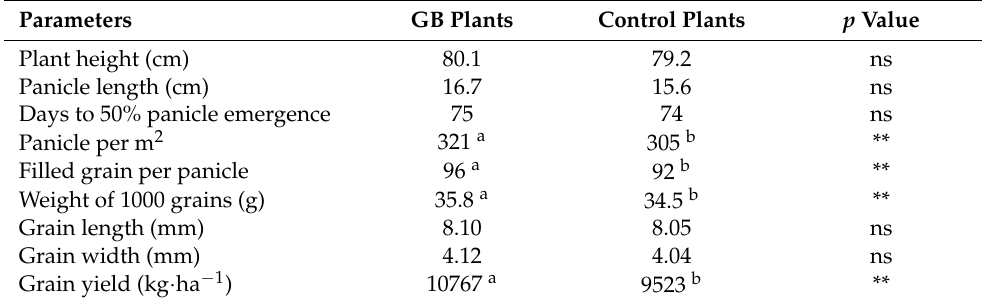
Table 2. Influence of glycinebetaine (GB) treatments on productive parameters of rice plants. Parameters GB Plants Control Plants p Value Plant height (cm) 80.1 79.2 ns Panicle length (cm) 16.7 15.6 ns Days to 50% panicle emergence 75 74 ns Panicle per m 2 321 a 305 b ** Filled grain per panicle 96 a 92 b ** Weight of 1000 grains (g) 35.8 a 34.5 b ** Grain length (mm) 8.10 8.05 ns Grain width (mm) 4.12 4.04